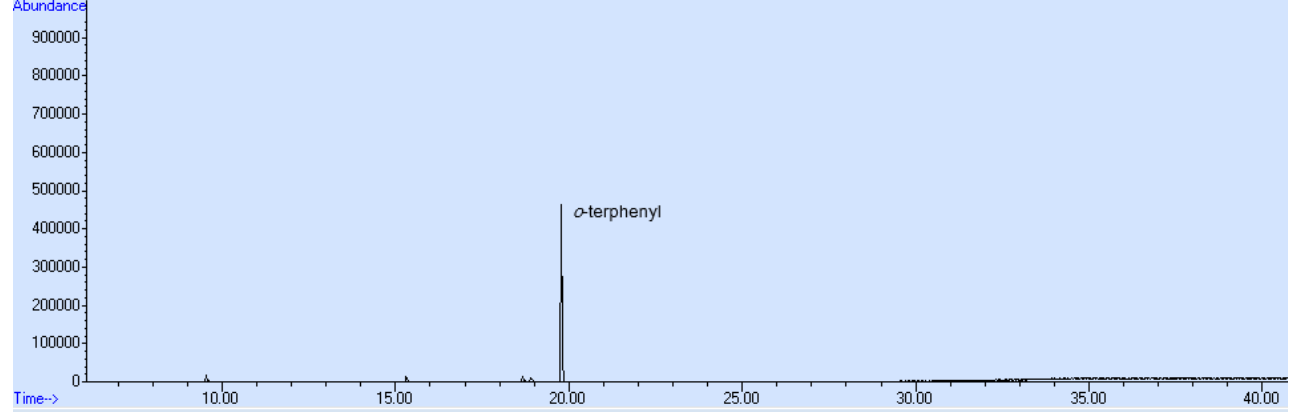
Figure 10. Indicative TIC of the sediment and water samples from the study area.